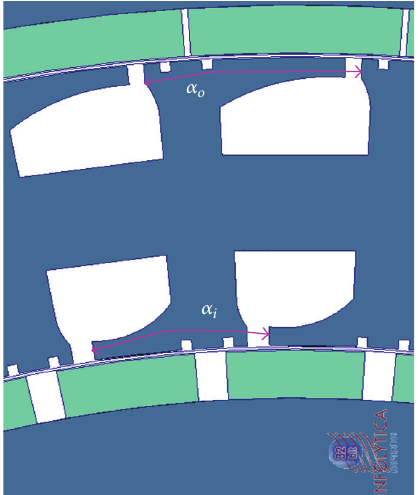
Figure 9: Section of FEA model showing shifted slot